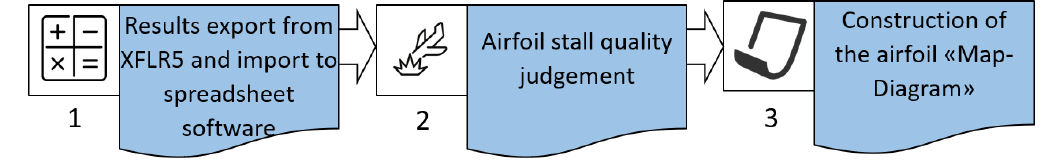
Figure 5. The steps were taken for results’ organization.